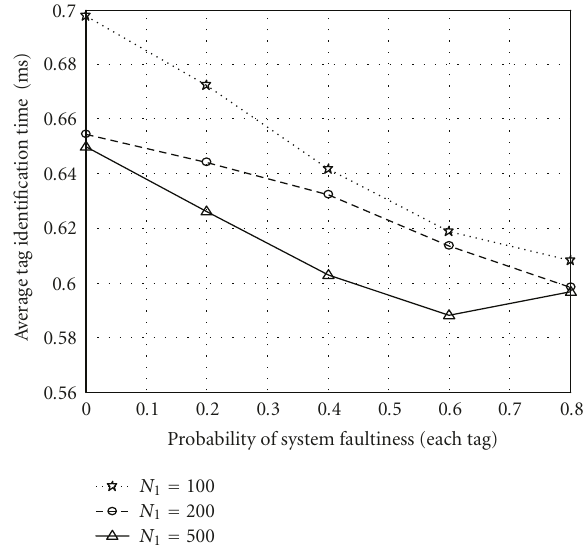
Figure 9: Performance of ASAP with limited frame size.